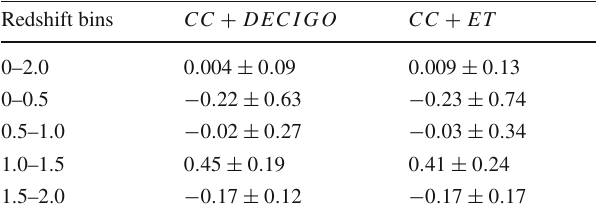
Table 1 Weighted average of Ω k in different redshift bins from the standard siren of GW detector (DECIGO and ET) and standard clock of cosmic chronometers